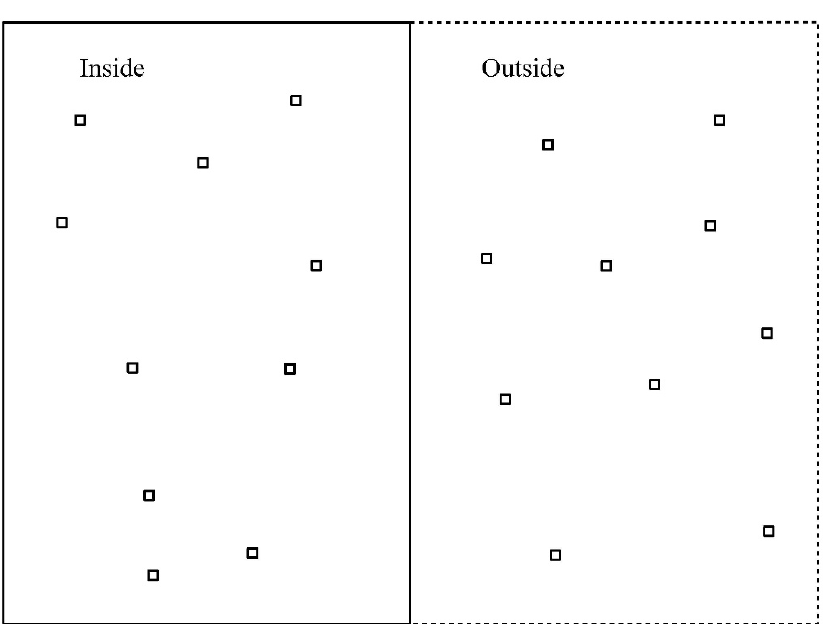
Figure 2. Layout of the quadrats in the experimental plot. A fence is installed along the border of the enclosure represented by the thick line, but not installed along the broken line which is outside the